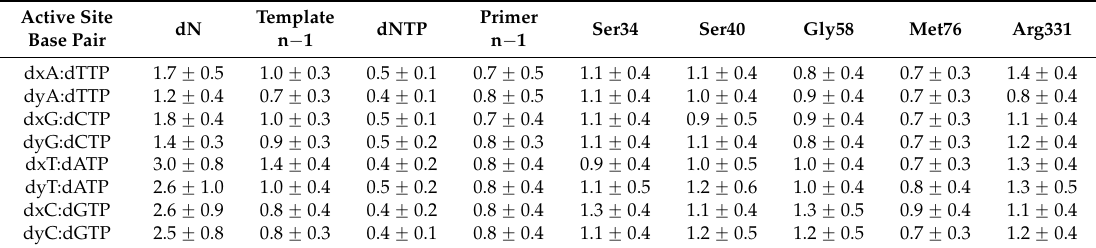
Table 6. RMSD (Å) in the backbone position in the Dpo4 ternary complex for the replication of a (x,y)DNA base compared to a natural base across the 40 ns MD simulation trajectories a . Active Site Base